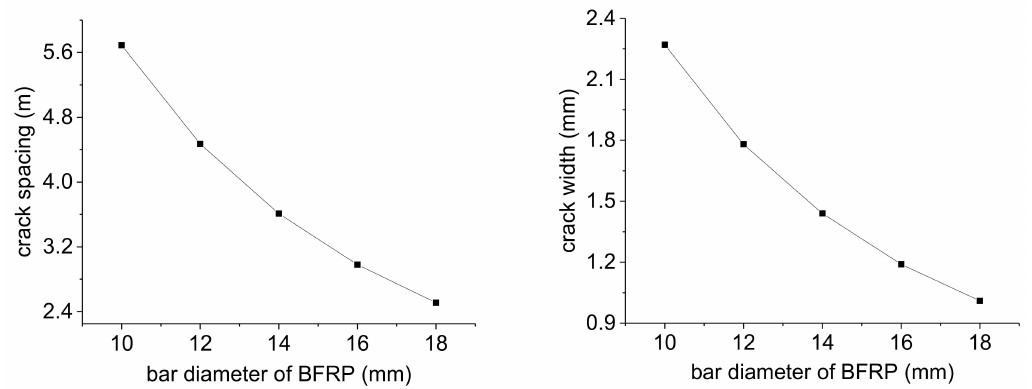
Figure 9. Impact of BFRP diameter on the crack spacing ( left ) and crack width ( right ) of CRCP with BFRP